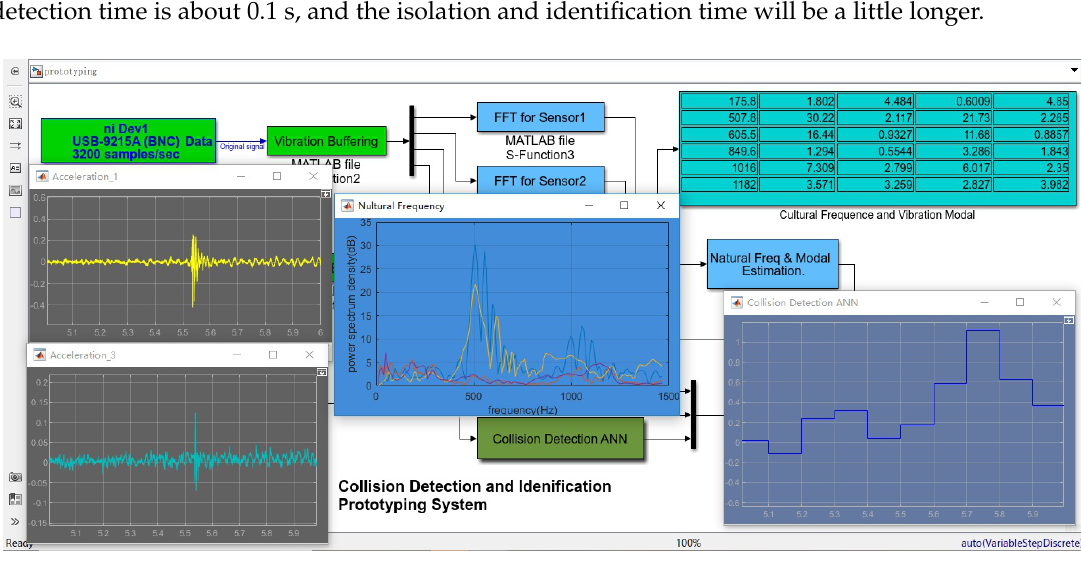
Figure 12. A Rapid Prototyping